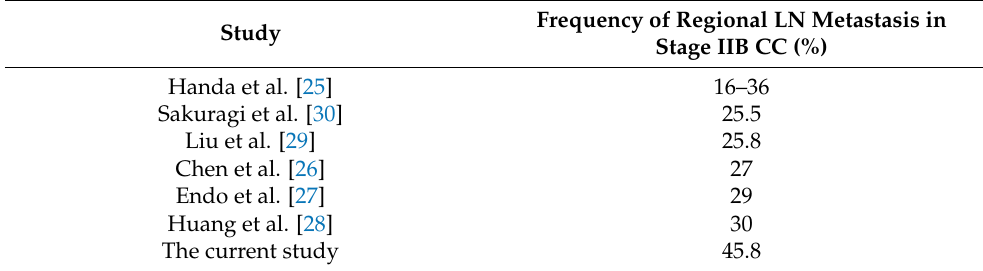
Table 4. List of studies reporting frequency of LN metastasis associated with FIGO stage